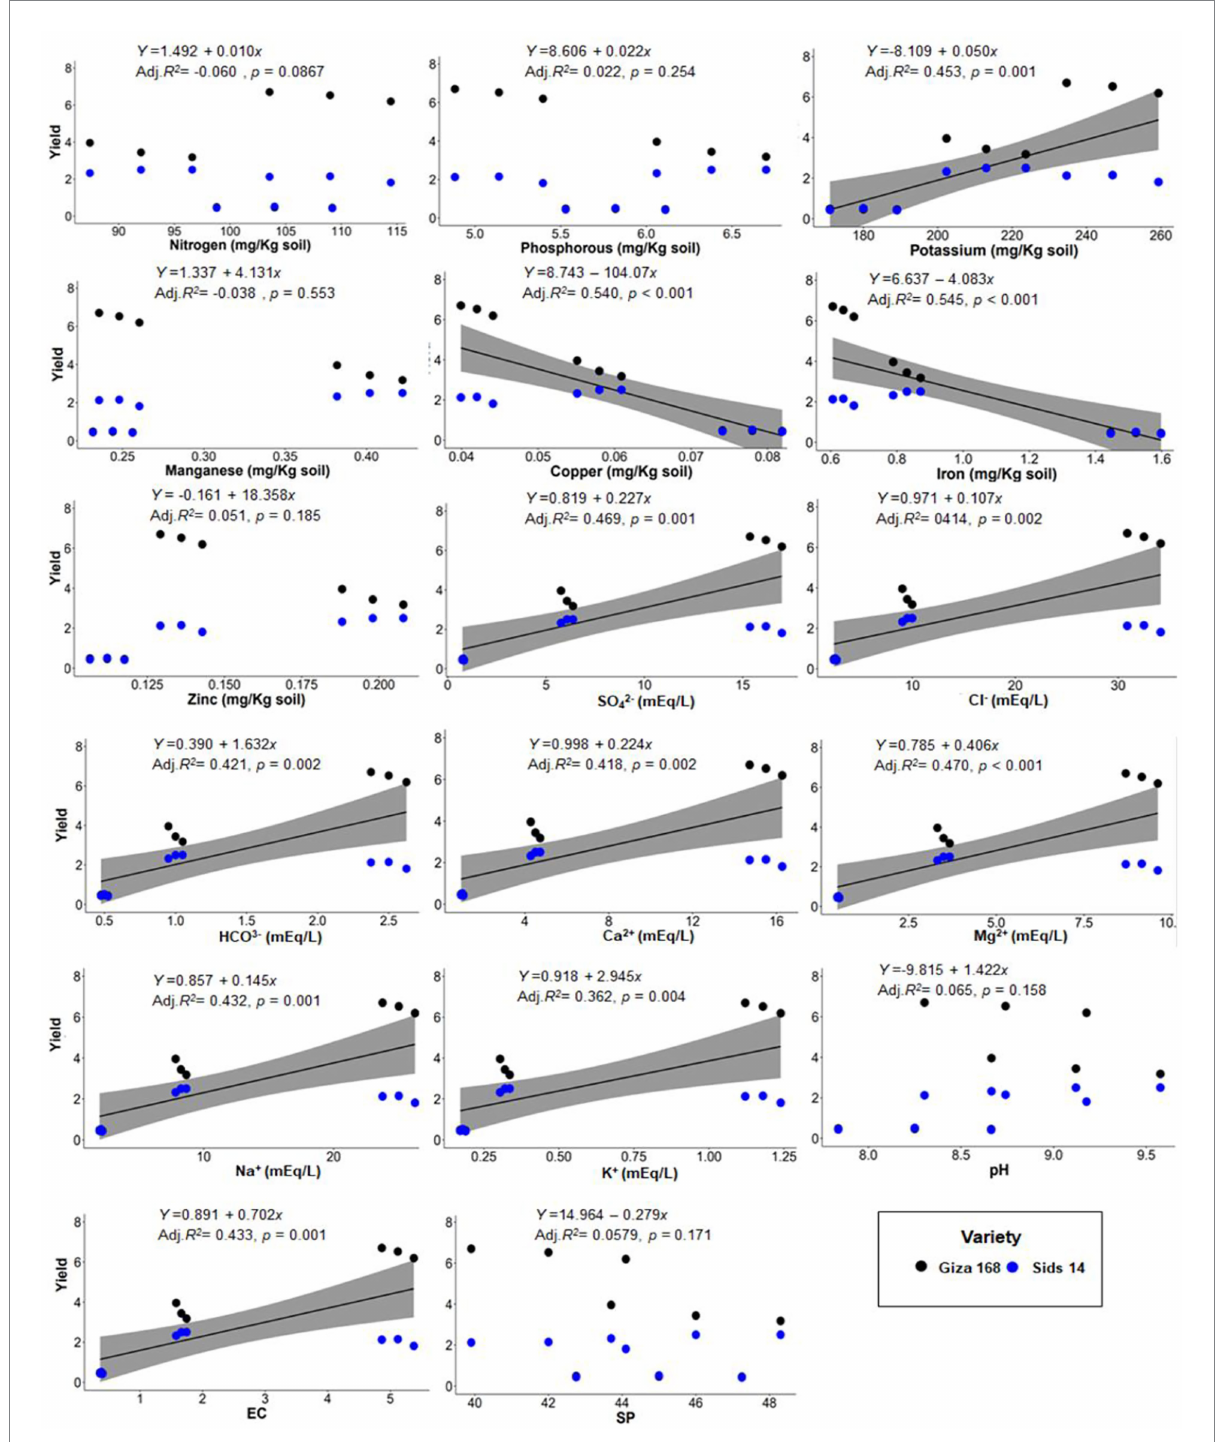
FIGURE 7 Simple linear regression analysis of the relationship between wheat yield and soil physicochemical